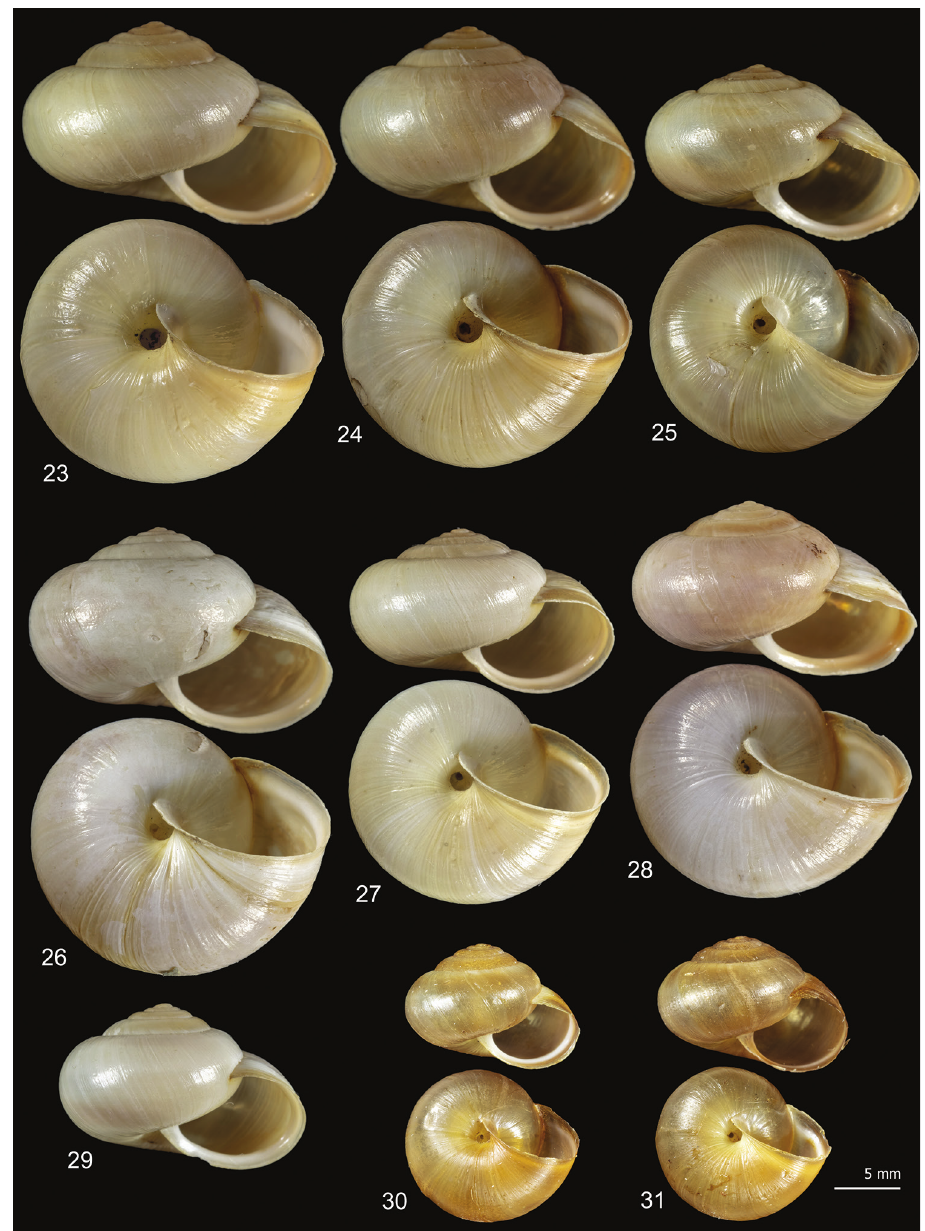
Figures 23–31. Shell variability in Monacha pantanellii from Via Salaria, Poggio San Lorenzo [Lor] (FGC 41551) ( 23–25 ), Valle dell’Aniene, Roccagiovine [Ani] (FGC 42974) ( 26–29 ) and Carsoli [Car] (FGC 41651( 30, 31